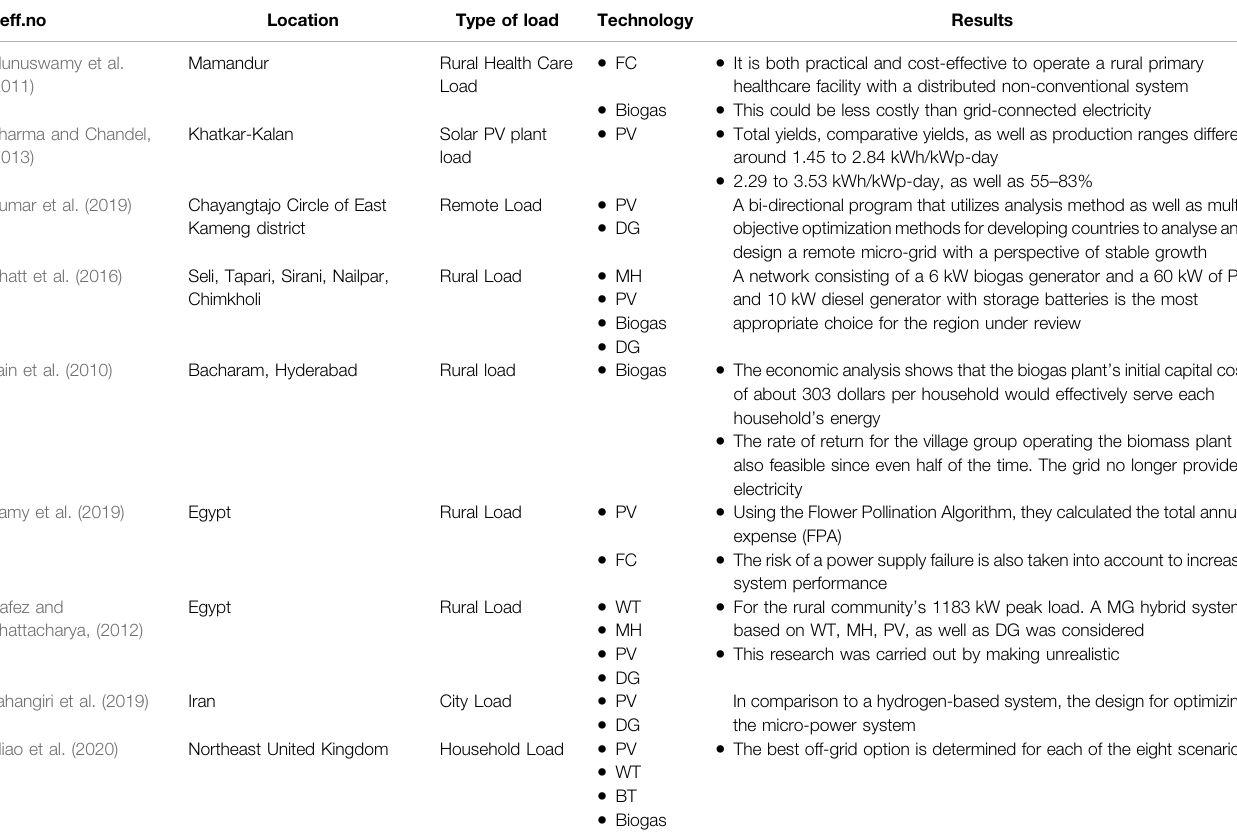
TABLE 1 | Summary of literature review.